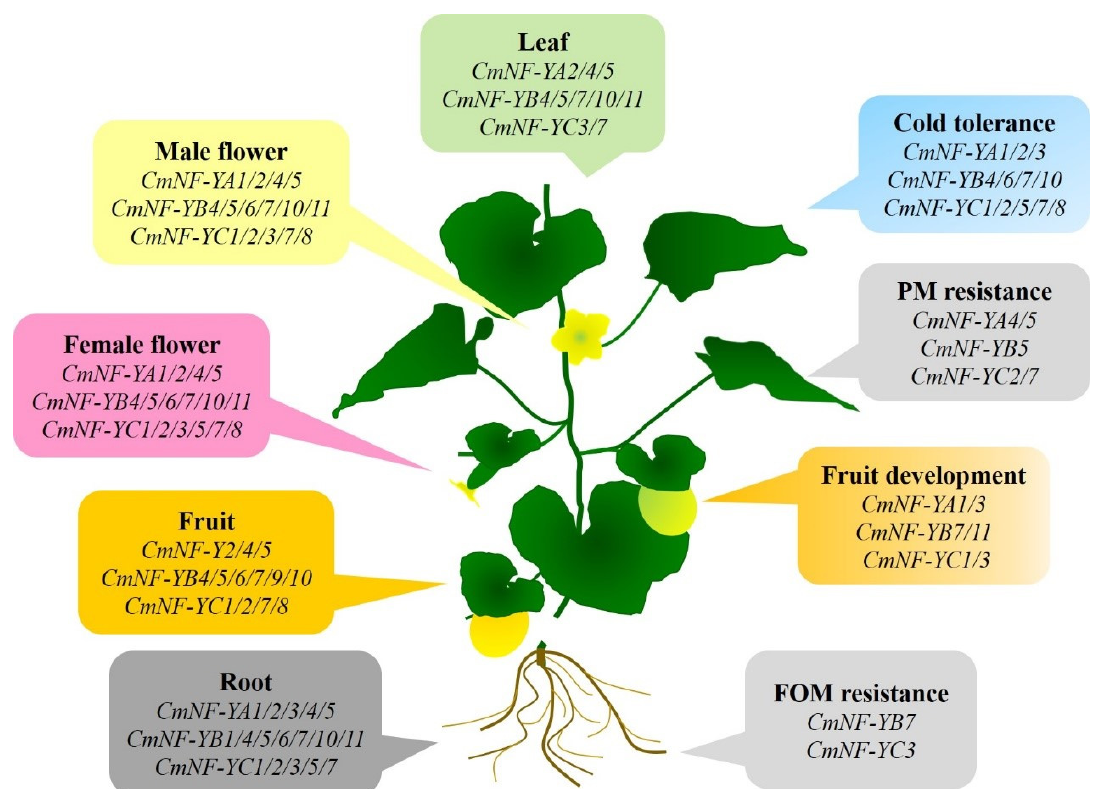
Figure 9. Schematic diagram of the probable function of melon CmNF-Ys . According to the tissue expression patterns and RNA-Seq data under stress, the probable biological processes that melon CmNF-Ys are involved in are summarized.